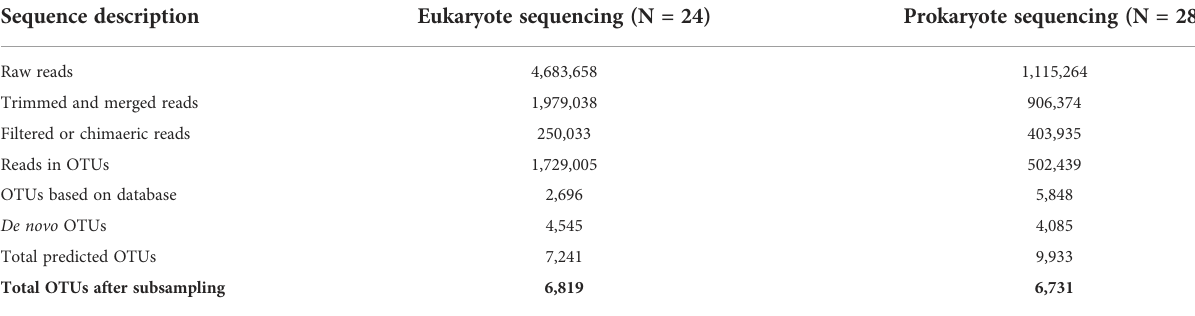
TABLE 1 Number of reads and OTUs obtained through the analysis of data obtained by eukaryote and prokaryote